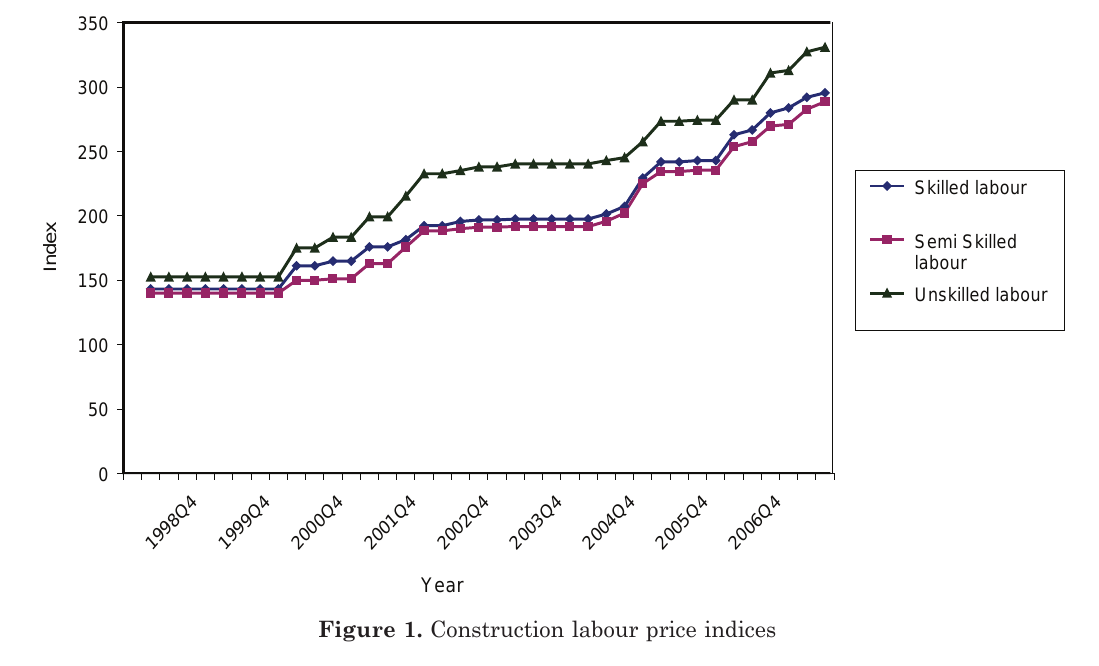
Figure 1. construction labour price indices